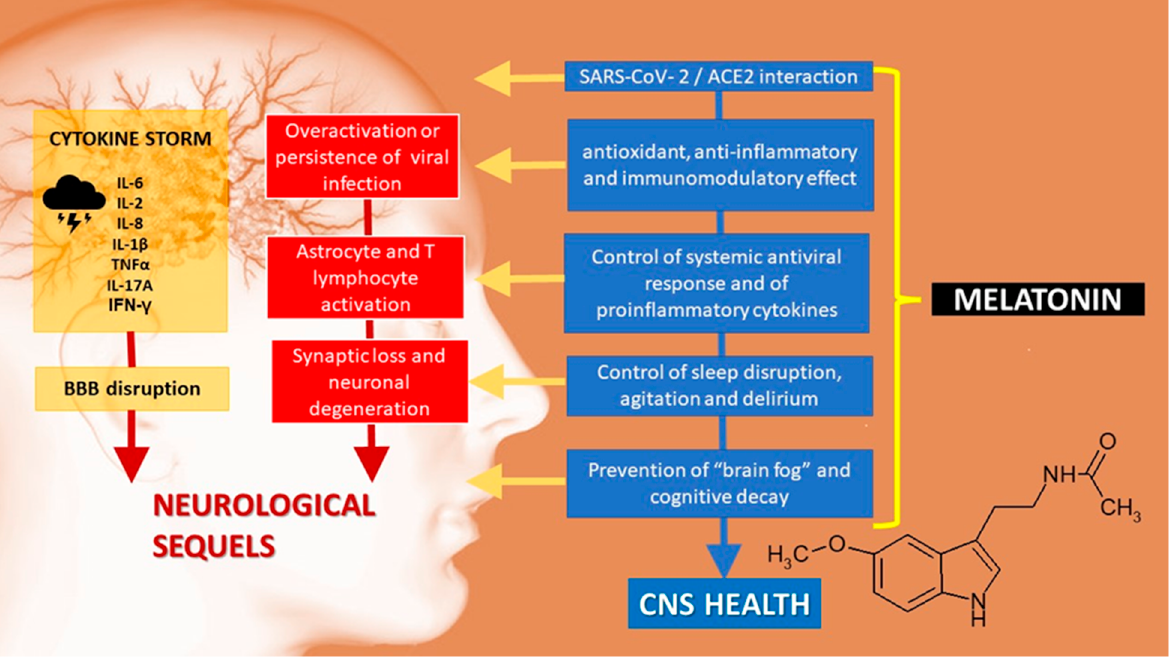
Figure 1. Central nervous system sequelae of SARS-CoV-2 infection. ACE2: angiotensin-converting enzyme 2. BBB: blood–brain barrier.